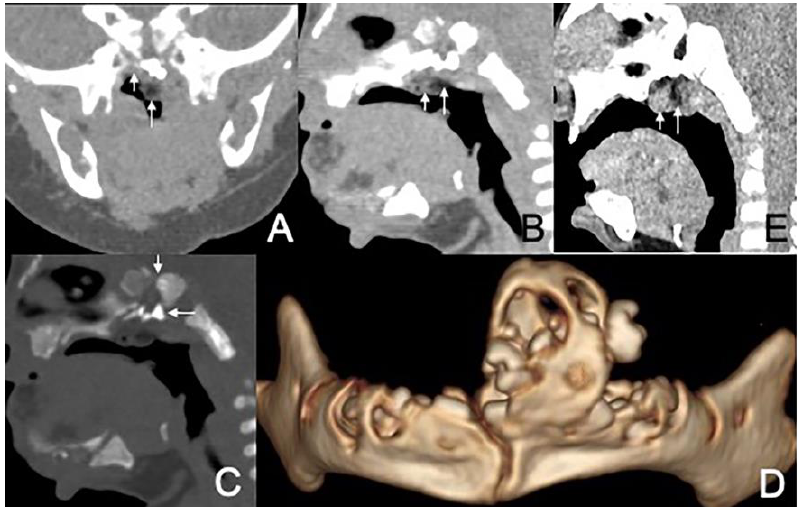
Figure 5. CT of a 1-month and 6-day girl presenting shortly after birth due to being unable to suck and having a mandibular mass. ( A , B ) Coronal and sagittal CT, displayed in the soft-tissue window, show the irregular fat (short arrow) and soft tissue (long arrow) density mass originating from the back side of the left soft palate. ( C ) Sagittal CT, displayed in the bone window, shows that there were multiple irregular dense shadows (long arrow) above the mass that were not seen, were excised during the transnasopharyngeal plasma surgery, and were probably ectopic teeth. In addition, the central bone defect of the sphenoid body was considered the remnant of craniopharyngeal canal development (short arrow). Intraoperatively, the nasopharyngeal apex wall was found intact, and no clear fluid outflow was observed. This patient was associated with cleft palate (not shown). ( D ) 3D reconstruction CT showing the associated ameloblastic fibro-odontoma of the mandible. ( E ) Sagittal CT after 3 years, displayed in a soft window, shows that the volume of the mass was increased slightly.